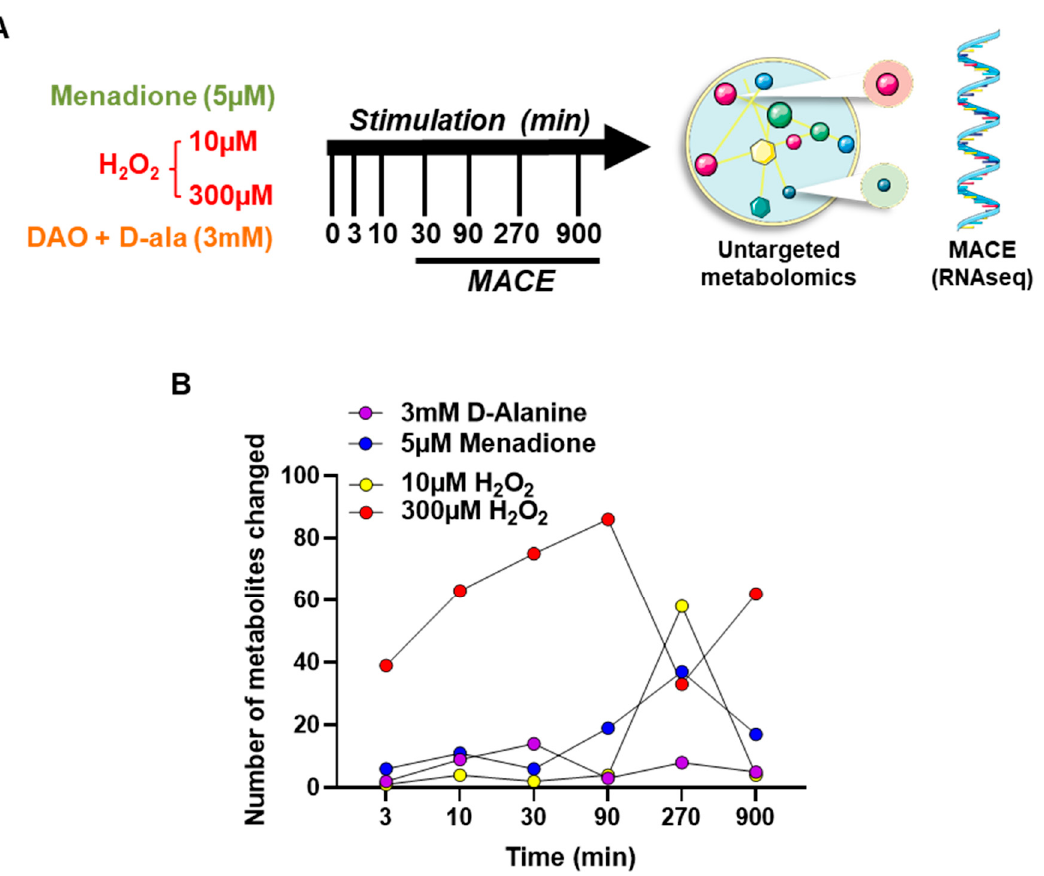
Figure 2. Time course analysis for metabolomics and transcriptomics of HUVEC with different oxidative stimuli. ( A ): Experimental design. ( B ): Number of metabolites significantly altered upon exposure to different ROS in HUVEC ( n = 3).